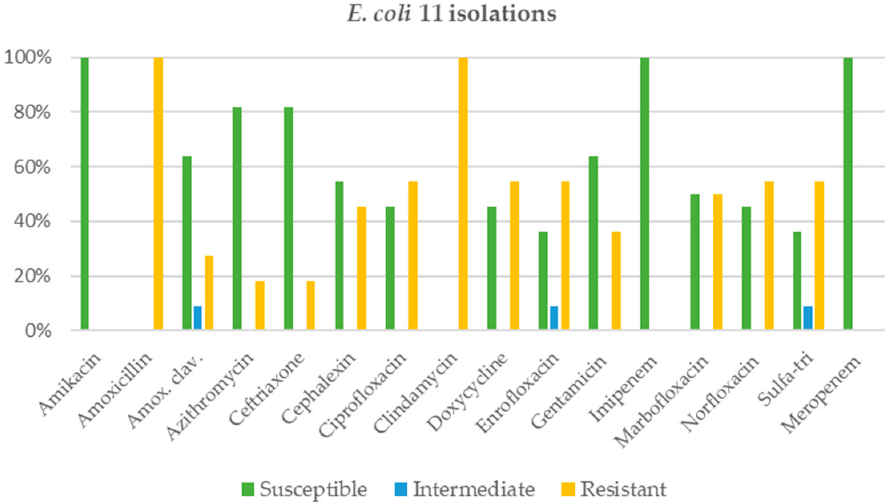
Figure 5. Activity of antimicrobials against E. coli in 11 isolations .